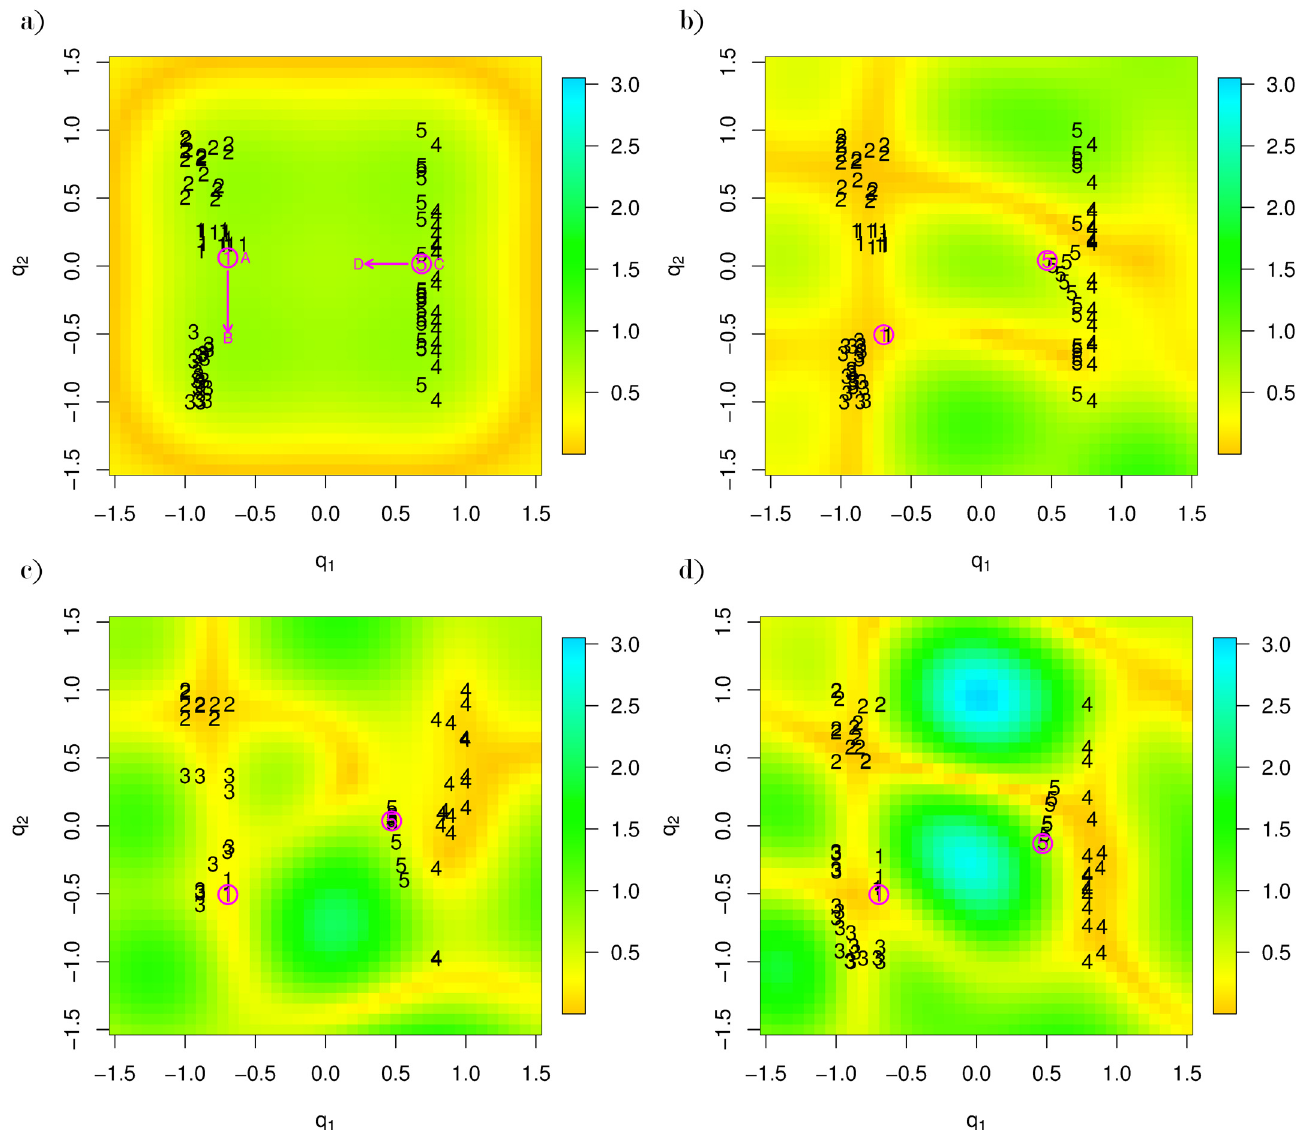
Fig 3. The progression of V2PI-GTM. Fig a is a GTM display (in latent dimensions q 1 , q 2 ) of the simulated dataset when K = 16, J = 400. The data points are labeled according to their cluster numbers. The arrows show how a user may interact. A user may move one point from location A to location B and another point from location C to location D. Figs b, c, and d show respectively how the observations respond (or do not respond) to the move when stages 1, 2, and 3 of V2PI-GTM are in